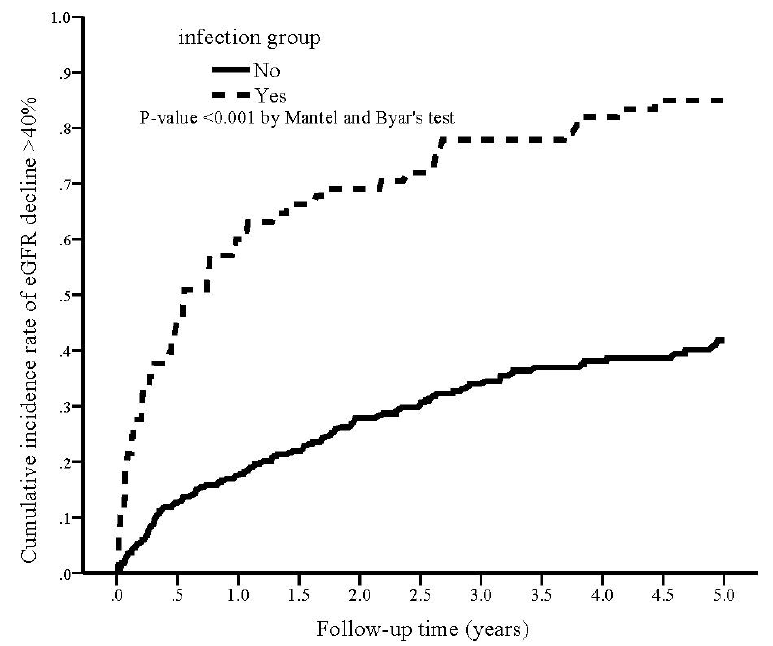
Figure 1. Kaplan–Meier curve of the cumulative incidence rate of eGFR decline > 40% for patients with and without infection (Mantel and Byar’s test, p < 0.001). Table 3. Stepwise Cox regression models of renal outcomes for infection/pneumonia groups.